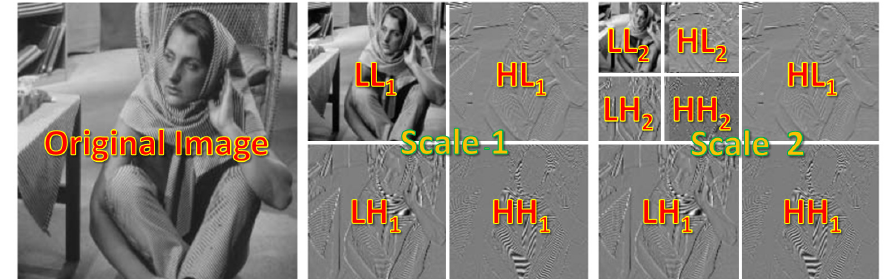
Figure 1. DWT decomposes the image into low–resolution coefficient maps. Here, the scale is 2. We use a scale of 1 to replace the down–sampling